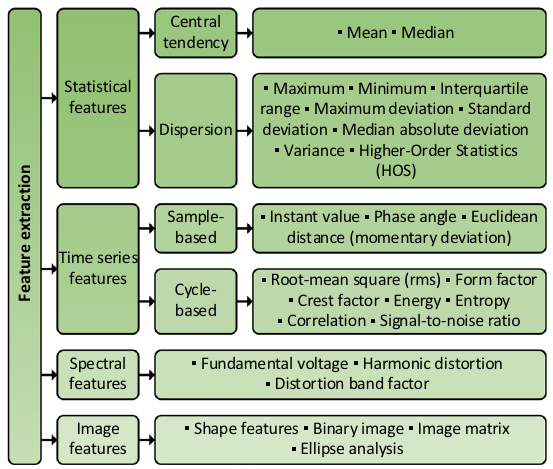
Fig. 10 Taxonomy of features for detection and